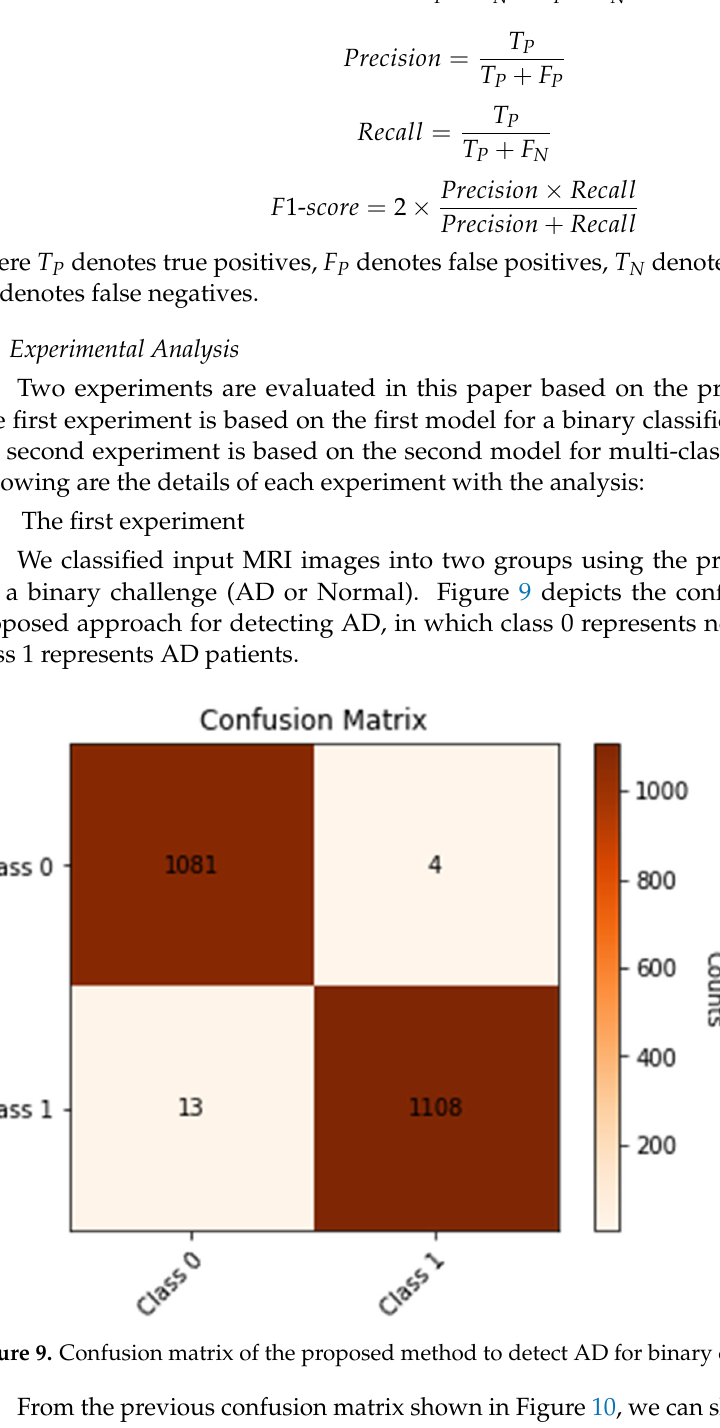
Table 4. The performance of the proposed model for binary classification task.